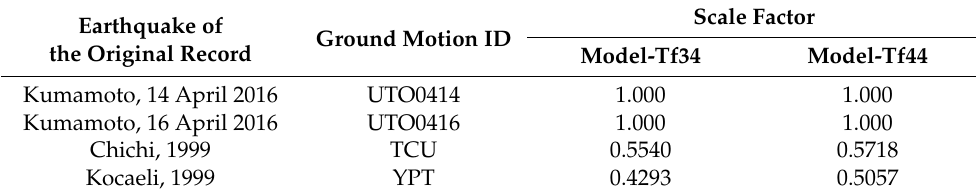
Table 5. List of the recorded ground motion datasets used in this